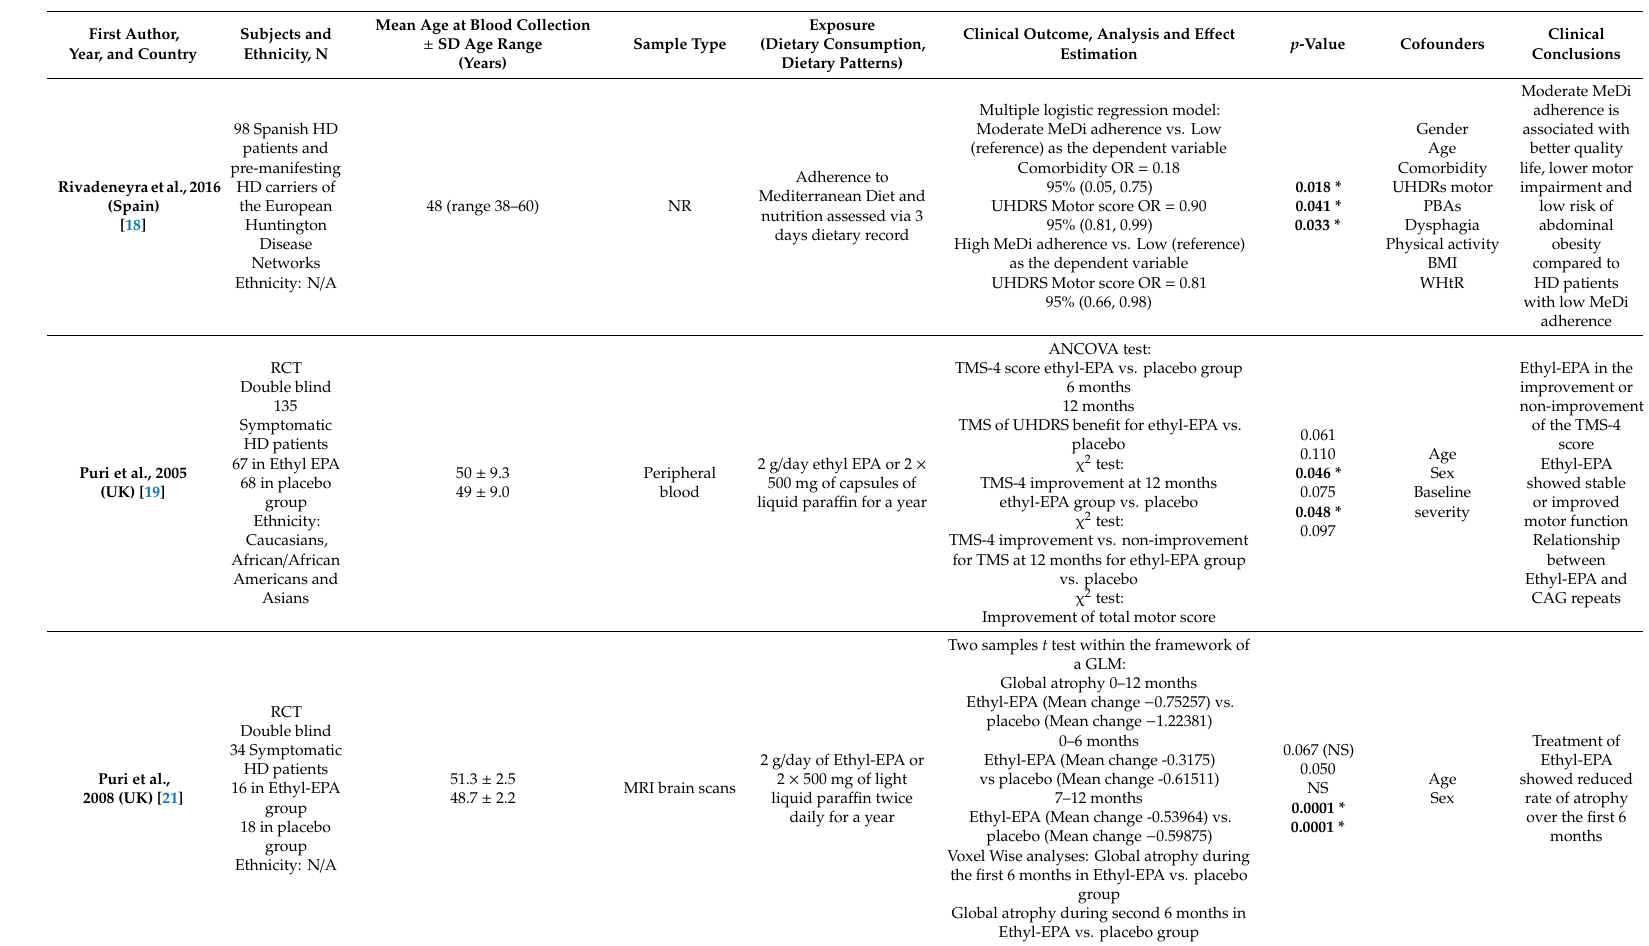
Multiple logistic regression model: Moderate MeDi adherence vs. Low (reference) as the dependent variable Comorbidity OR =